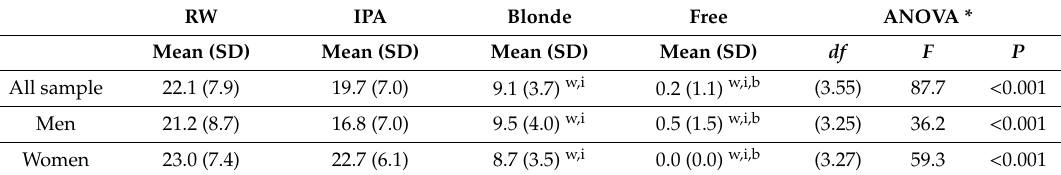
Table 6. Ethyl Glucuronide (EtG) urinary recovery (0–24 h). Results are expressed in µ moL.